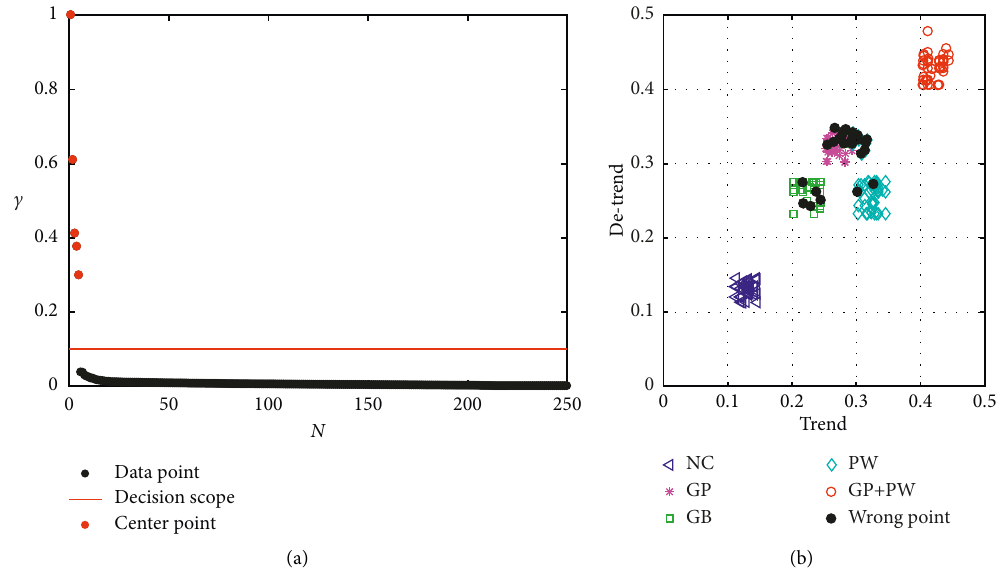
Figure 16: The clustering result of the gearbox by using the EEMD-FDE-DPC: (a) decision graph and (b) clustering